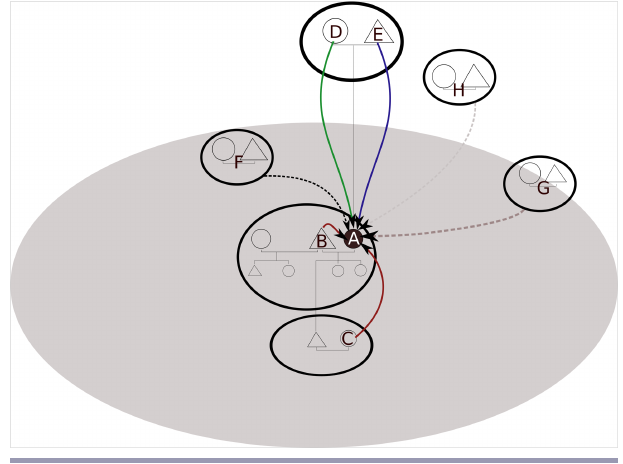
Fig. 1 . Illustration of the main social relationships between seed givers and recipients. The focal recipient A is in black. The shaded area represents the neighborhood area. Households are defined by a black circle. Males are represented by triangles and females by circles. Thin black lines represent genealogical relations. Seed diffusion among relatives is represented with thick-line arrows with in-laws in brown (e.g., B-A and C-A), uterines in green (e.g., D-A), and agnates in blue (E-A). Seed diffusion among nonrelatives is represented using dashed-line arrows with neighbors in black (e.g., F-A), friends in dark grey (e.g., G-A) and acquaintances or strangers in light grey